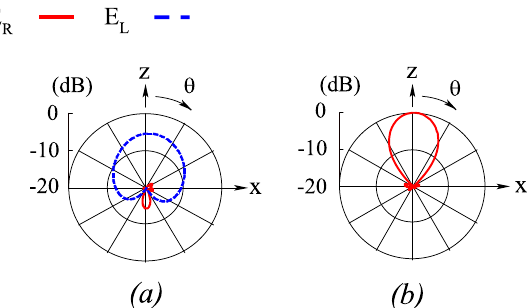
Fig. 21. Normalized radiation pattern for the square metaloop-C antenna. (a) At frequency f GLmax =2.58GHz near f N1 = 2.60GHz. (b) At frequency f GRmax =3.51GHz near f